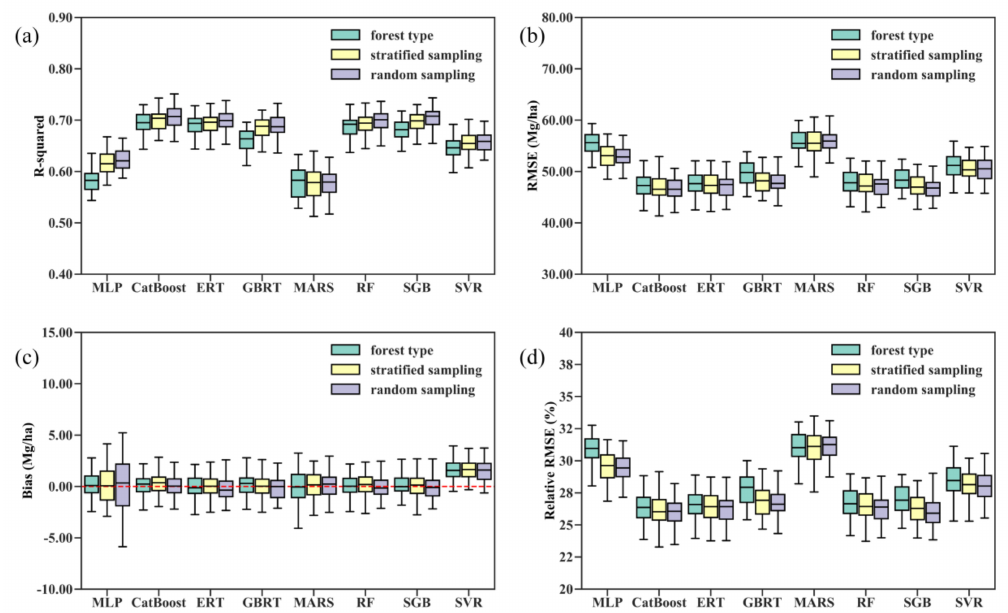
Figure 3. Distribution of the 50 validated ( a ) R-squared, (b ) RMSE, ( c ) bias, and ( d ) relative RMSE values for each machine learning regression algorithm under three modeling scenarios. Random sampling corresponds to AGB modeling without stratification of forest types, stratified sampling corresponds to AGB modeling with stratification of forest types, and forest type corresponds to separate AGB models for each forest type